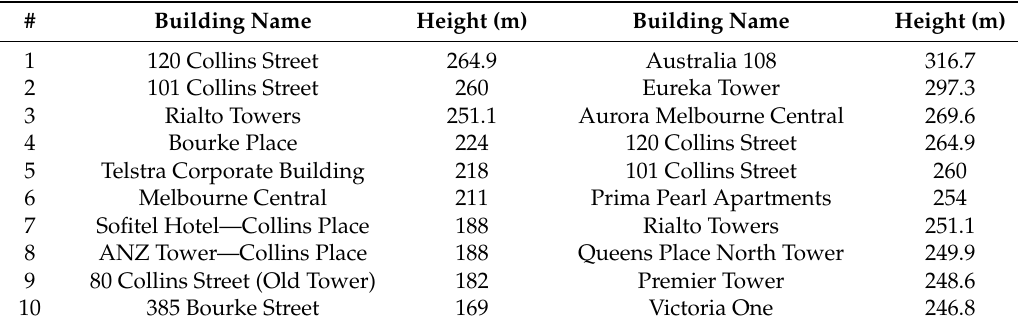
Figure 13. Melbourne in 2000 and 2020. Table 23. Melbourne’s 10 tallest skyscrapers in 2000 and 2020.